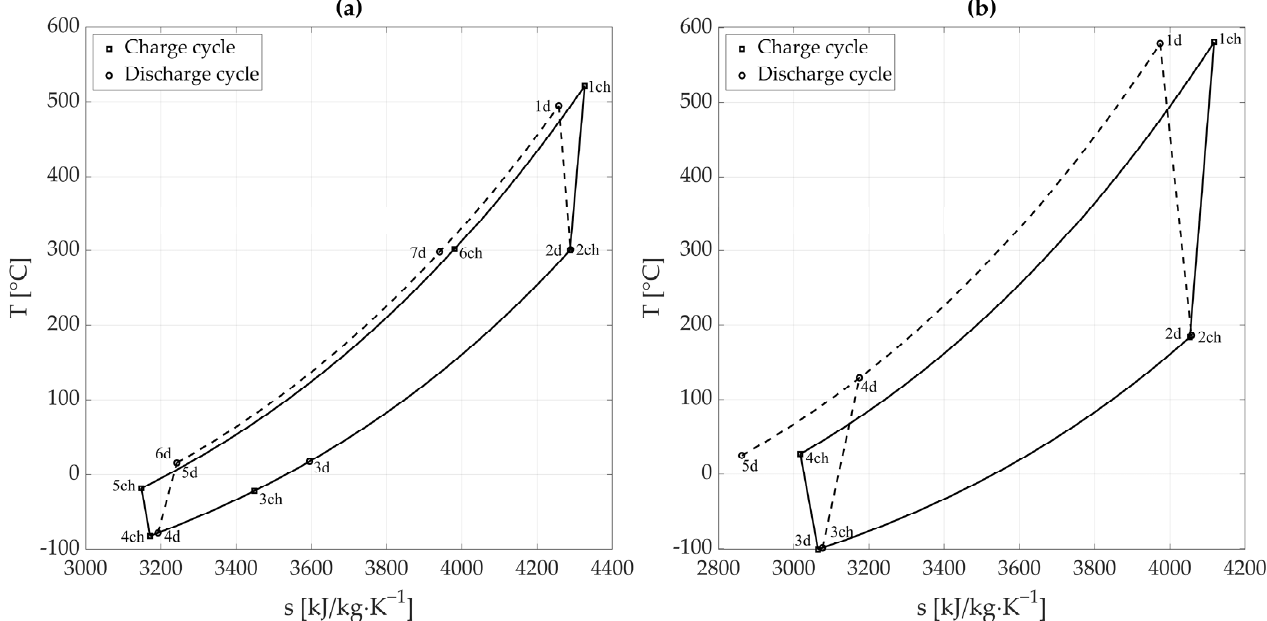
Figure 3. Brayton PTES systems thermodynamic charging and discharging cycles: ( a ) system with solid-based thermal exergy storage (SBPTES); ( b ) system with liquid-based thermal exergy storage (LBPTES).